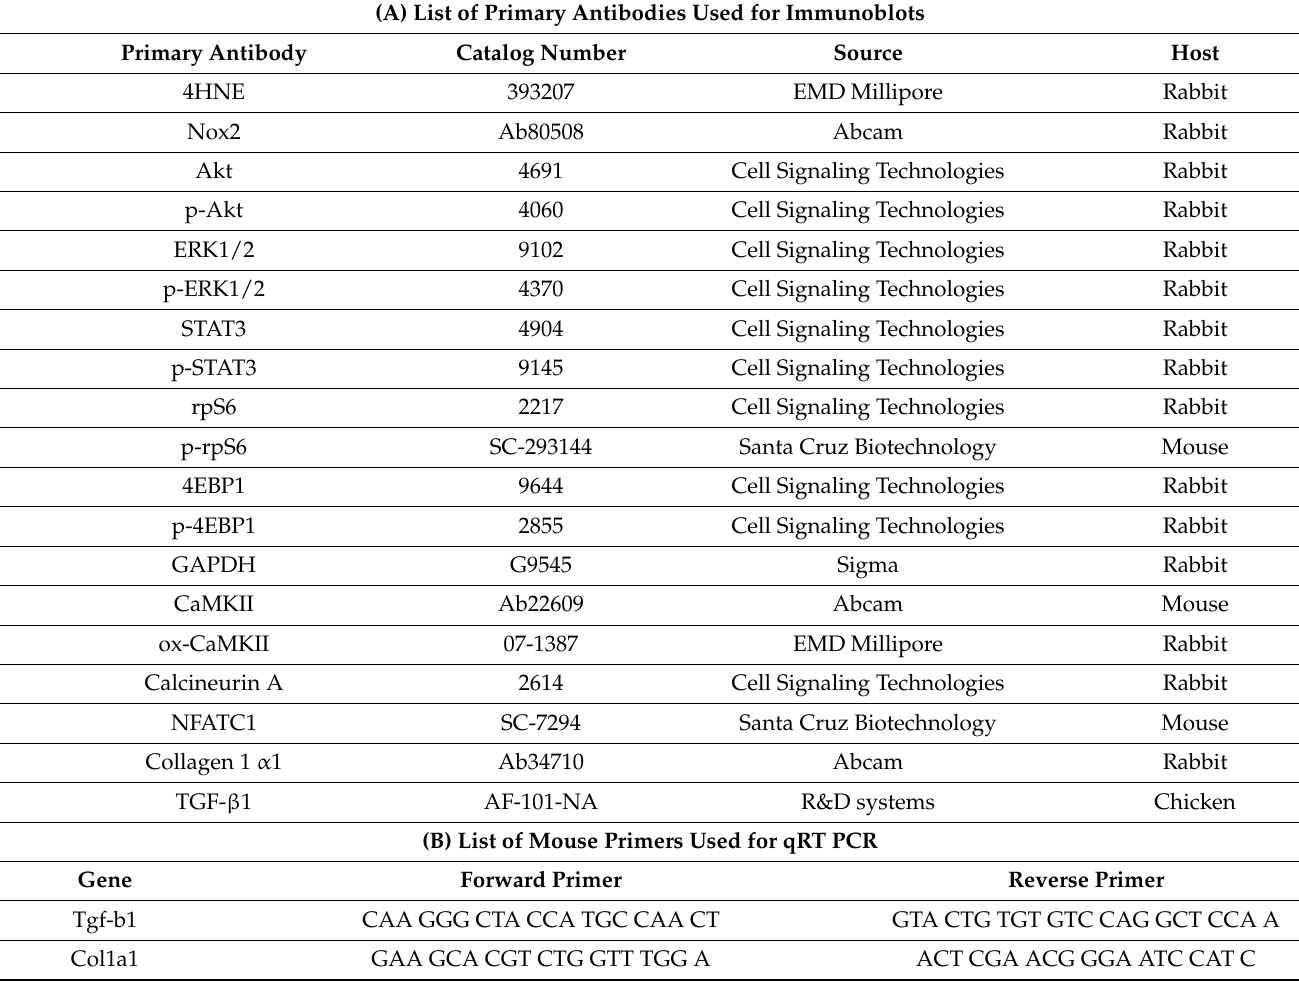
Table 1. Sources of antibodies and primers used for the study. (A) List of Primary Antibodies Used for